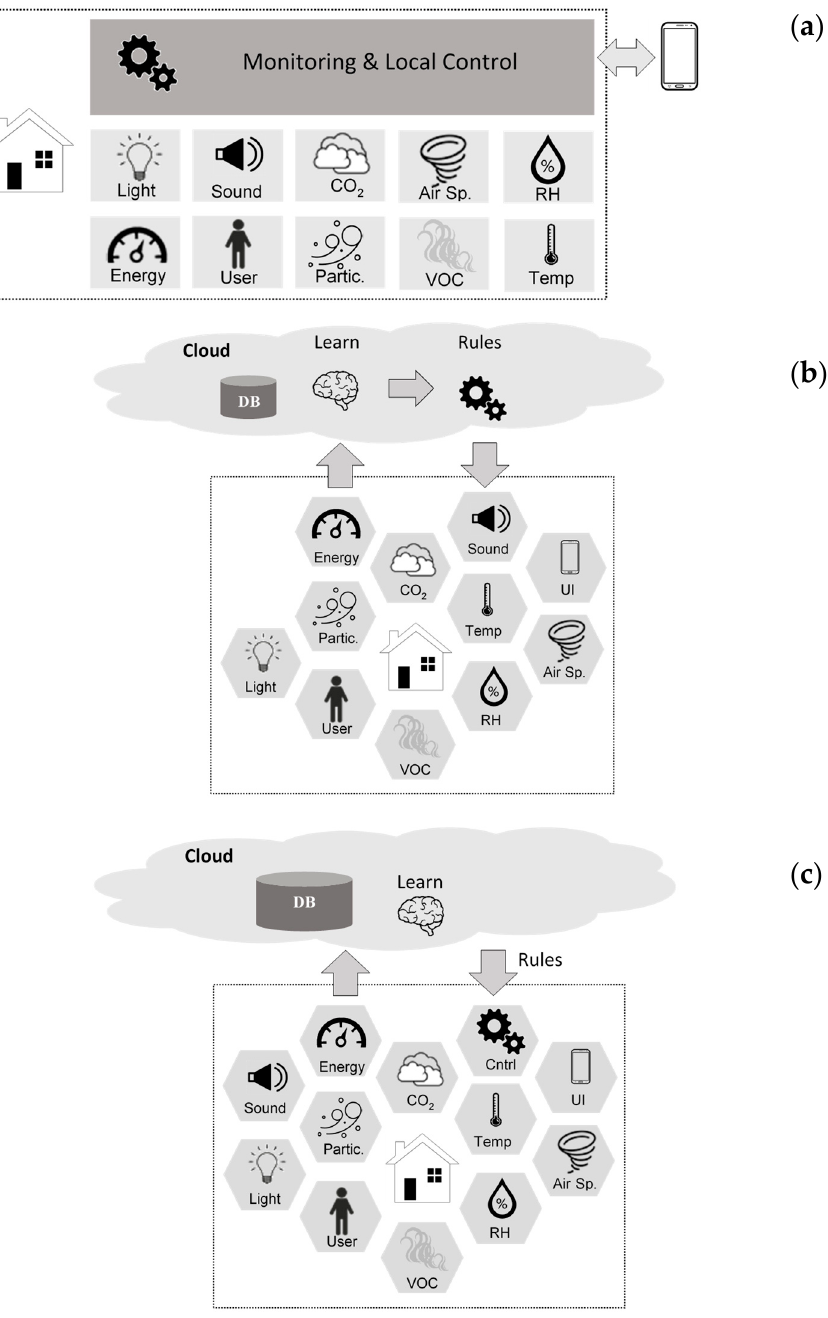
Figure 3. A comparison of different computational architectures for building automation: ( a ) the traditional approach; ( b ) full cloud computing approach; and ( c ) edge computing approach. UI: User Interface, DB: DataBase, VOC: Volatile Organic Compound, RH: Relative Humidity, Air Sp.: Air Speed.